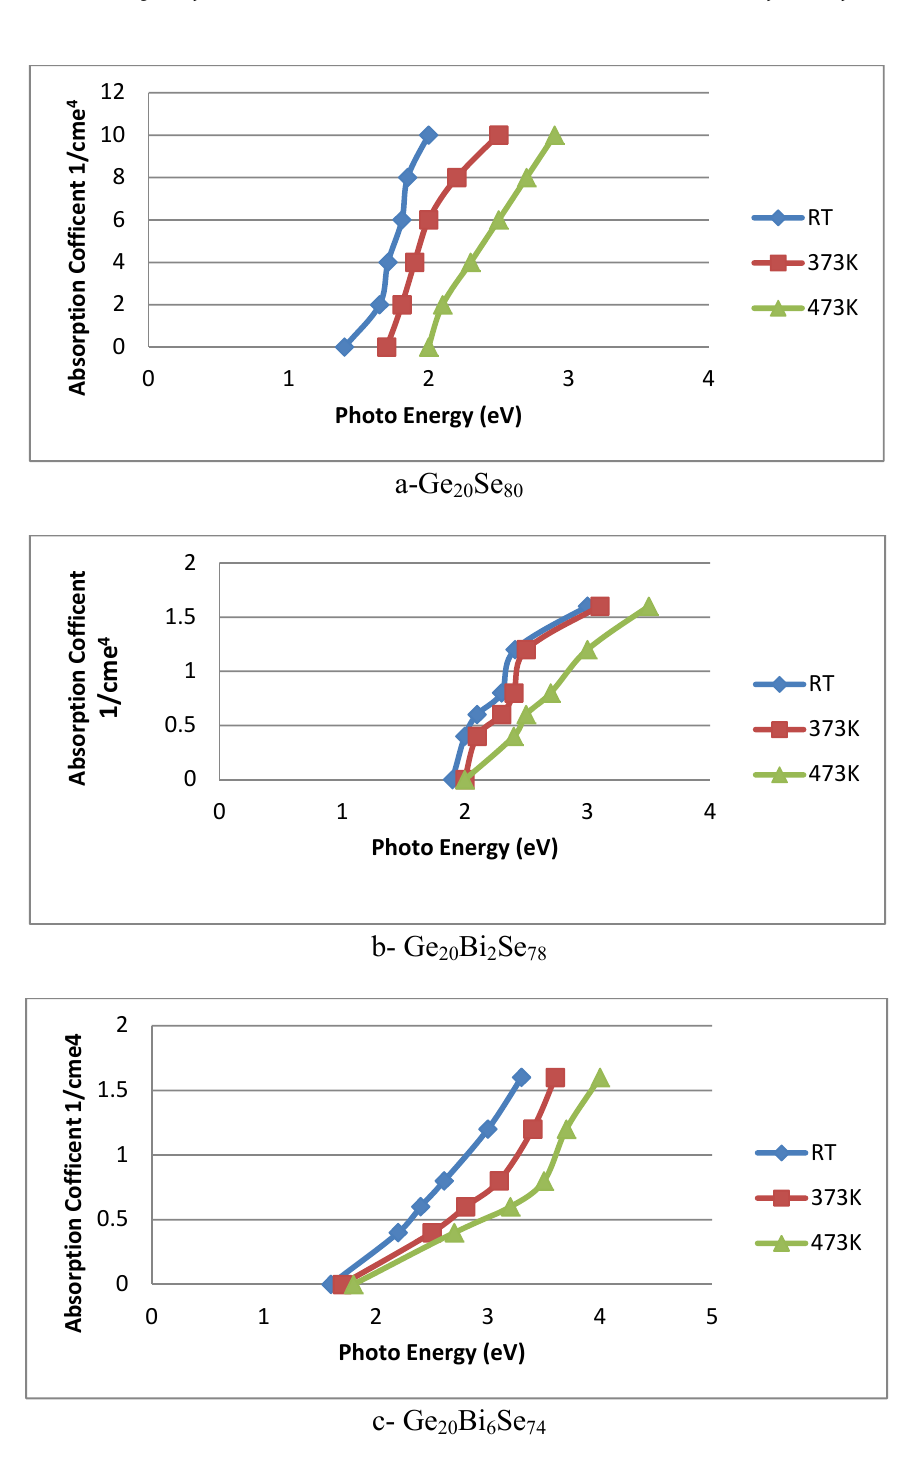
Bi Se films before and after 20 x 80-x